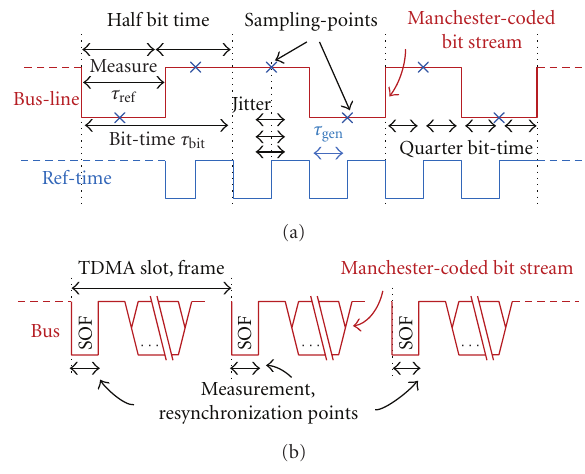
Figure 8: Manchester code with sampling points (a), TTP-slots, resynchronization